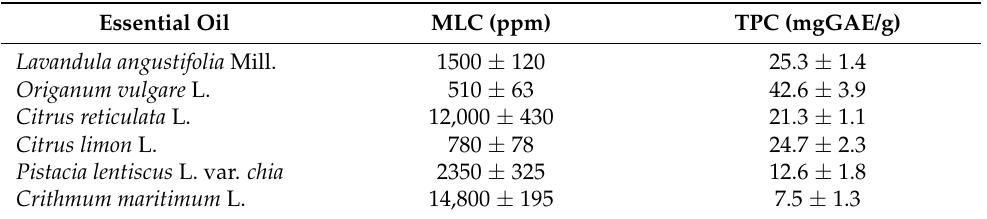
Table 2. Minimum lethal concentration (MLC) ( n = 3) and total phenolic content (TPC) ( n = 3) of the six essential oils analyzed.